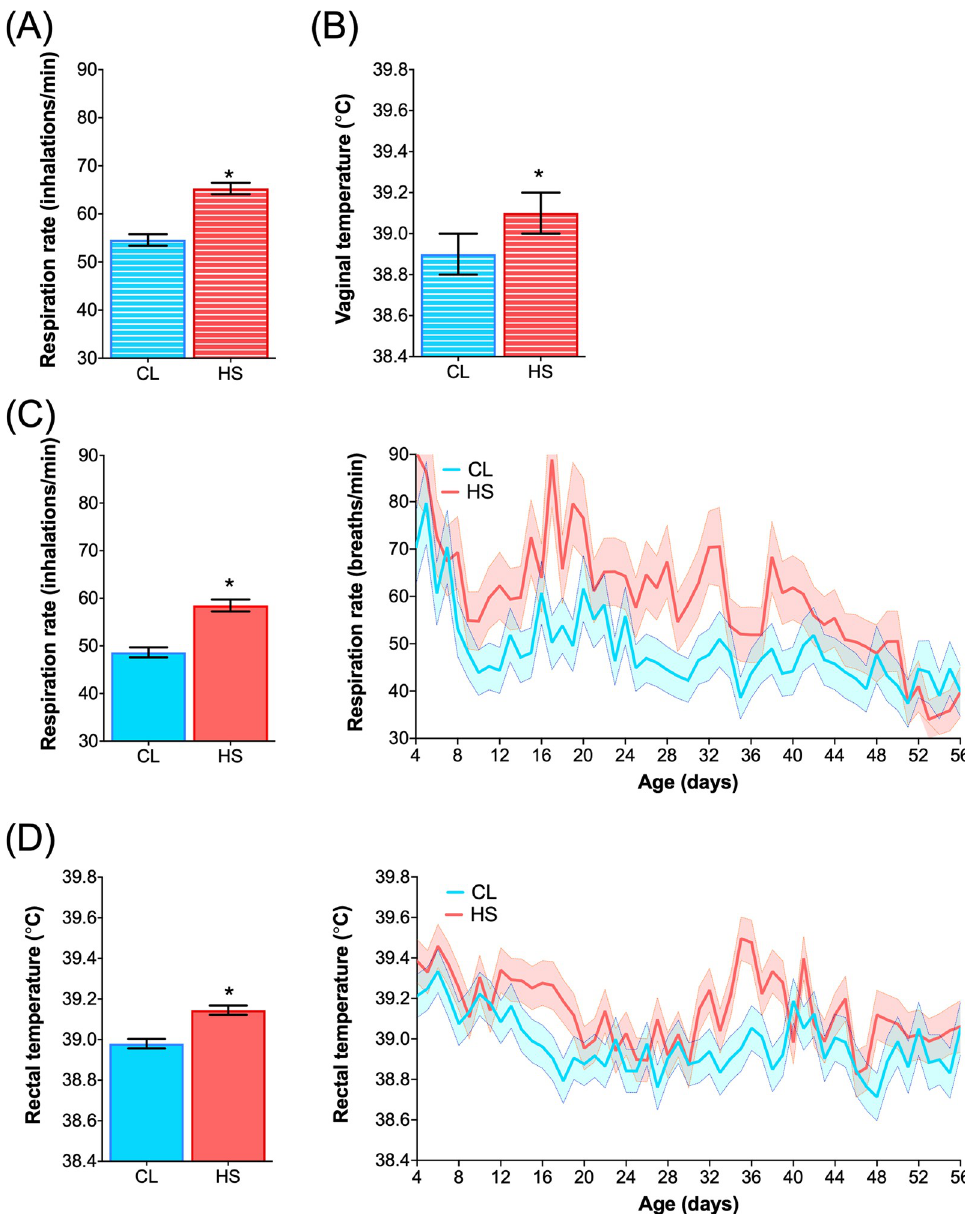
Fig 2. Respiration rate and body temperature in dams and dairy calves. Dam’s ( A ) respiration rate (inhalations/min) recorded twice a week for 6 weeks prior to calving, and ( B ) vaginal temperature recorded every 10-min during weeks 6, 4 and 2 prior to calving illustrated as the LSM of the treatment. Dairy calves’ ( C ) respiration rate and ( D ) rectal temperature measured daily at 1300 h across the pre-weaning period (56 d) illustrated as the LSM of the treatment (left-graph) and as the LSMs of the treatment by day interaction (right-graph). Dairy calves were exposed to heat stress (HS; n = 6) or heat stress abatement (CL; n = 6) across pre- and postnatal phases (late gestation and pre-weaning) for a total of 102 d. Blue and red bars with horizontal white lines denote CL dams (prenatal CL exposure) and HS dams (prenatal HS exposure), respectively, whereas blue and red bars denote dairy calves’ postnatal CL and HS exposure, respectively. No treatment by day interaction effects were found between dam’s or calves respiration rate or body temperatures ( P > 0.15). ( � ) indicate significance ( P � 0.05). Data was adapted from Dado-Senn and colleagues, 2020 [1].